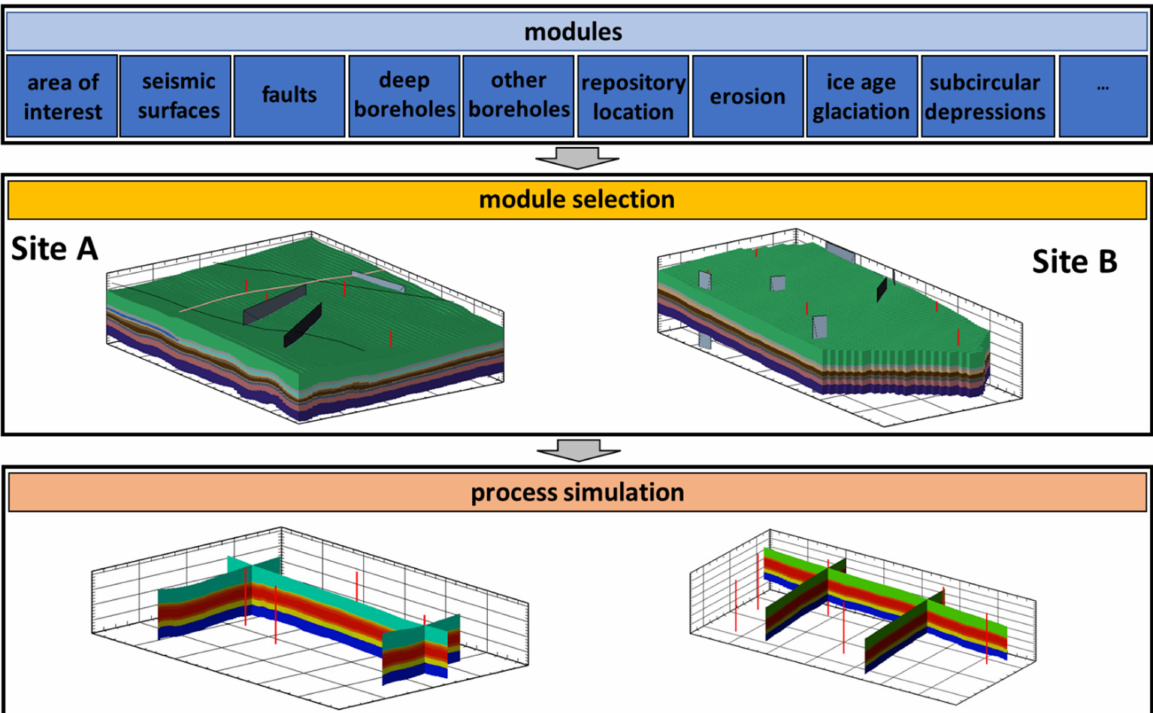
Figure 3. Modular structure adopted for the implementation of site-specific models individually tailored to specific assessment